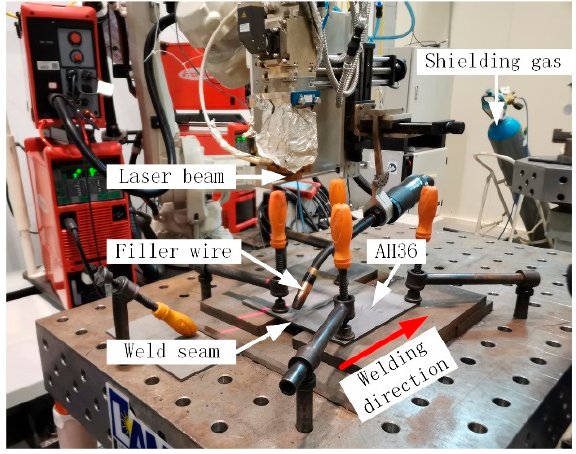
Figure 1. Laser-MIG hybrid welding equipment.